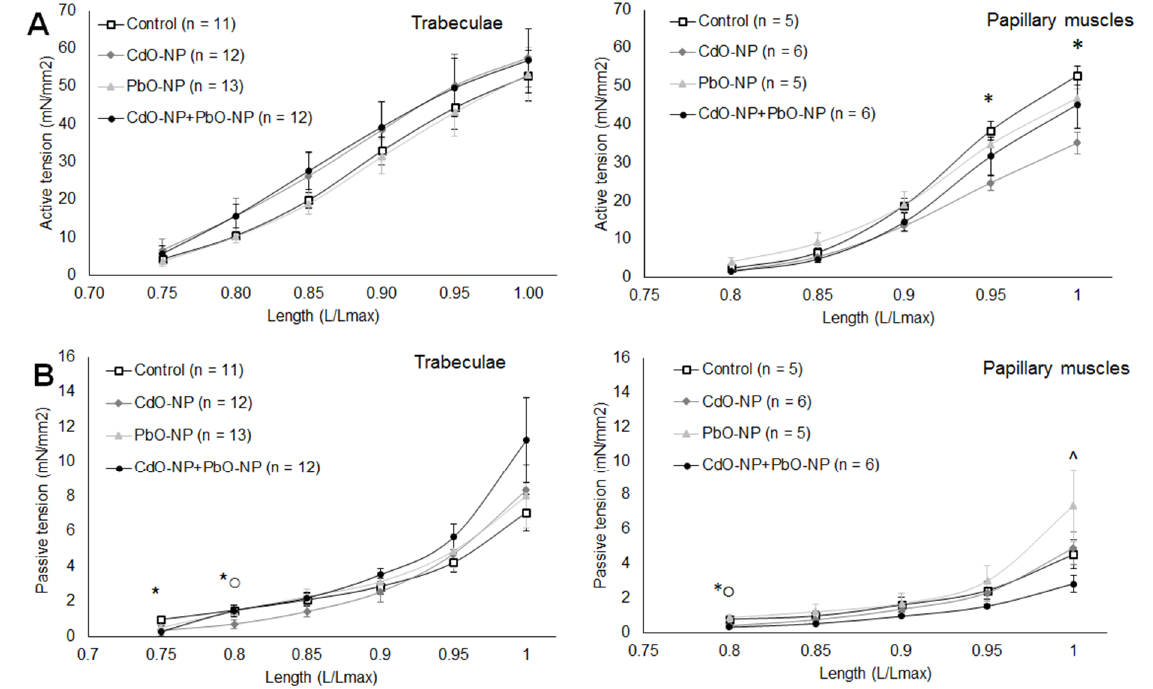
Figure 3. The relationships of the amplitude of active tension ( A ) and passive tension ( B ) vs. relative muscle length, obtained for trabeculae (left panels) and papillary muscles (right panels) of the control, PbO–NP and CdO–NP groups. Muscle length is shown in L MAX units. Data are shown as mean ± s.e. There are significant differences: *—CdO–NP vs. Control, ^—CdO–NP + PbO–NP vs. PbO–NP, ○ —PbO–NP vs. CdO–NP ( p < 0.05 ) .